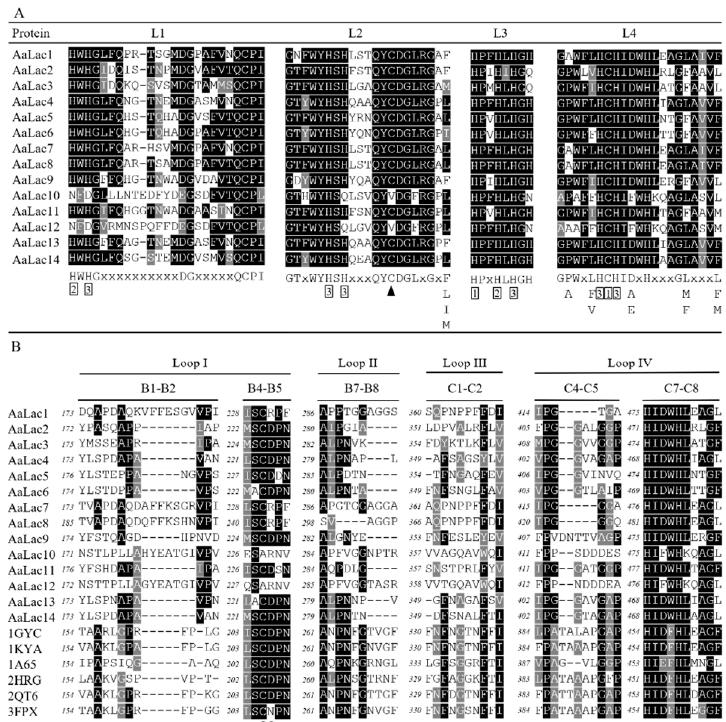
Figure 3. The signature sequences and postulated substrate binding loops of A. areolatum laccase. ( A ) The signature sequences (L1–L4) of AaLac1–AaLac14. The typically conserved ten histidine and one cysteine residues of the copper-binding centers are numbered according to the copper type (1, 2, and 3 for type-1, type-2, and type-3, respectively) they bind [50]. The black triangle marks the cysteine (C) residue in signature sequence L2, which is always present in classical laccases but not in Mco1 and Fet3 ferroxidases [51,52]. ( B ) The substrate binding loops (I–IV) of AaLac and known three-dimensional structures. The black circle underneath the sequences indicate residues in the β -hairpin loop B4–B5, which in the classical laccases are a highly conserved cysteine (C) and either an aspartic acid (D) or a glutamic acid (E) existed in T. versicolor LacIIIb to contact with organic substrates [53]. The identical and similar residues are represented by black and grey shading.